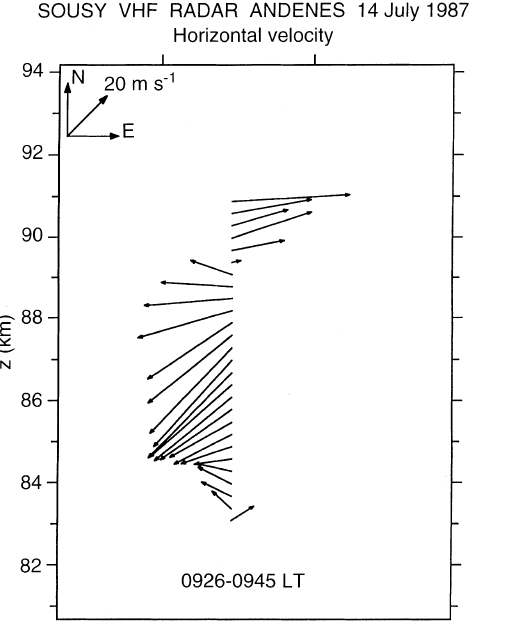
Fig. 5. Scatter plots of total spectral width and wind speed at heights above ( circles ) and below ( asterisks ) 86 km for weak ( upper panel ) and strong ( lower panel ) turbulence. The solid and the dashed lines indicate the limits of one- and two-way beam